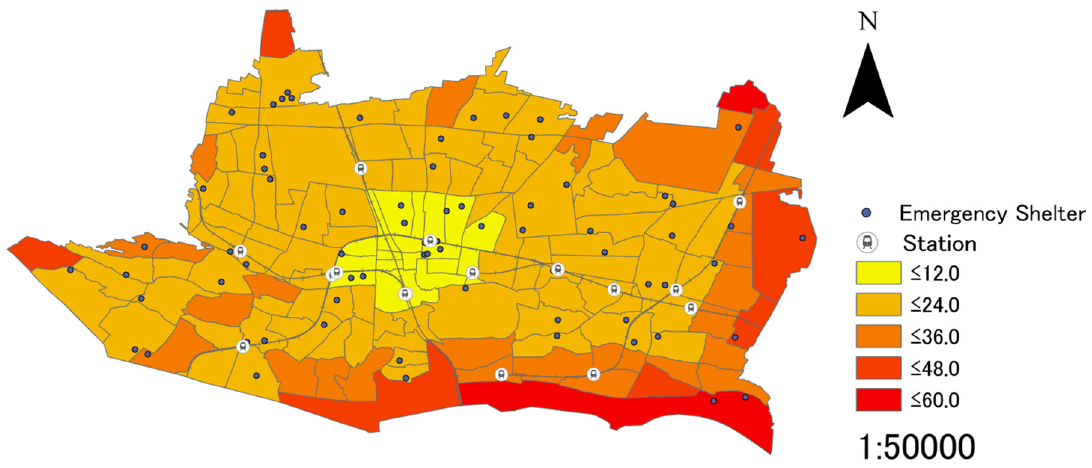
Figure 6. Result for Fuchu City without a weighted coefficient.